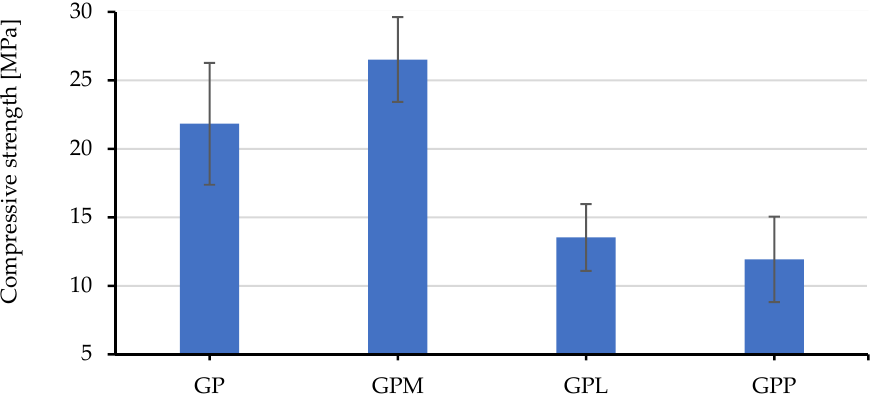
Figure 4. The compressive strengths of the studied samples.